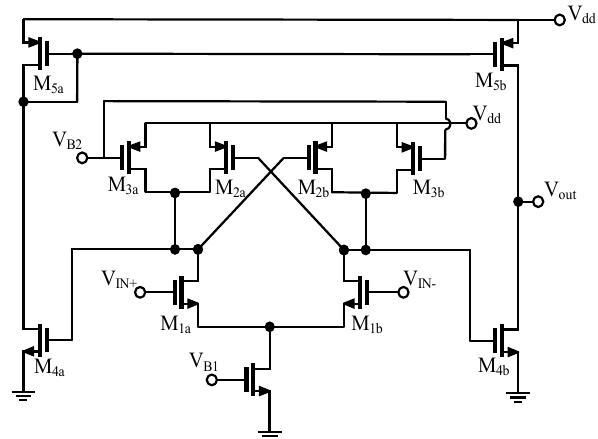
Figure 3. The proposed two-stage Schmitt trigger.